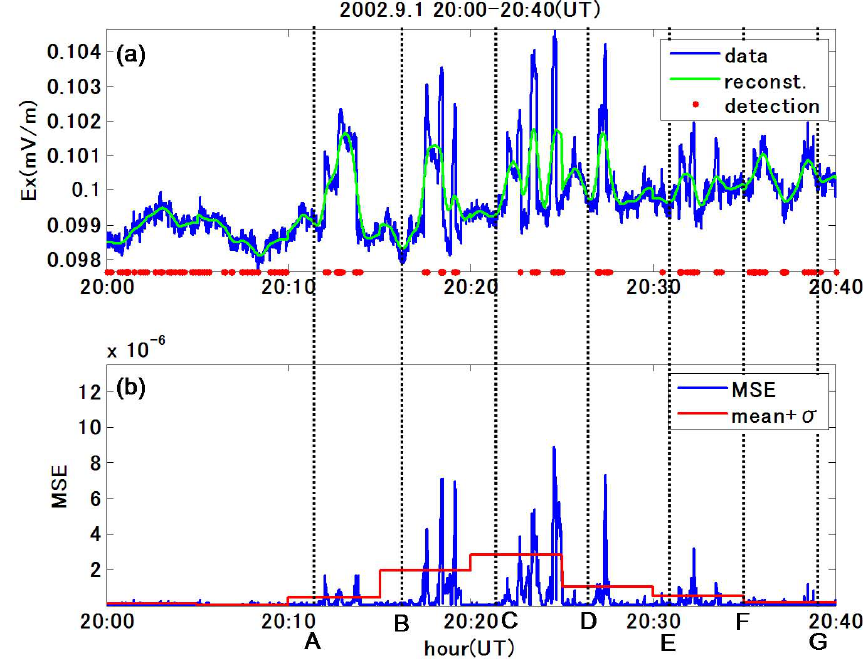
Fig. 18. An example of the DC-driven train noise detection in Ex component. The analyzed period is 20:00–20:40, on 1 Septem- ber 2002(UT). (a) The observed data and the reconstructed data using SSA decomposed components with high correlation values. (b) MSE and the threshold